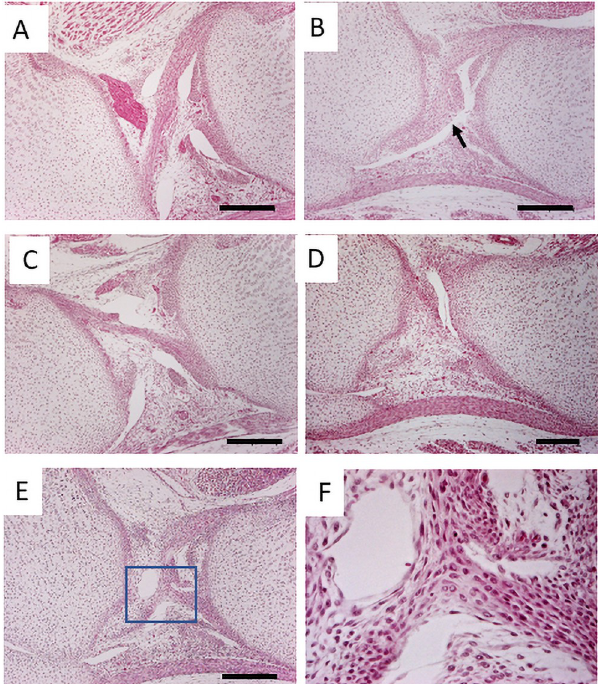
Fig 2. The histological analysis of newborn mice. A, C. The knee joint of Prx1-Vcan +/+ . B. Prx1-Vcan joint. Note disorganized ACL (arrow). D. Prx1-Vcan joint. Note that the patella fat and anterior femoral region are connected with broader tissues. E. Prx1-Vcan joint. ACL and PCL are disorganized and indiscernible (Bar = 200 μ m). F. High-power view of the rectangle in E. Cells in the ligament are in different sizes, oriented to different directions.